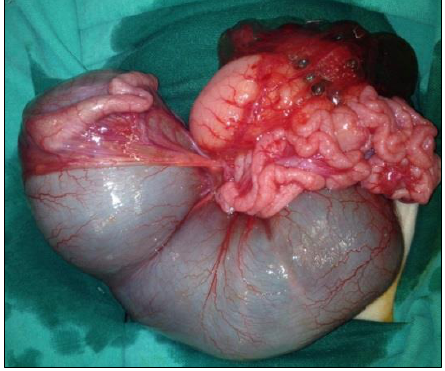
Figure 1: Jejunal Atresia, ideal for such technique.